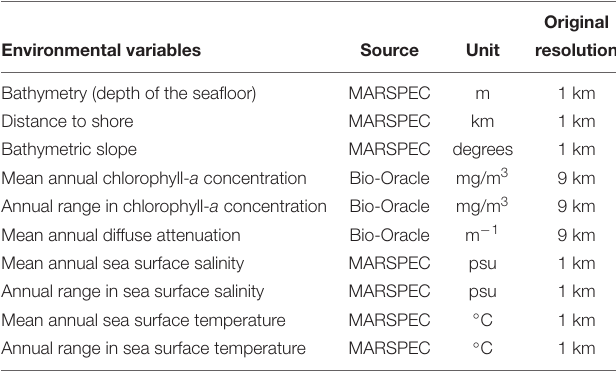
TABLE 1 | List of environmental variables used in this study and their respective source, original grid resolution, and unit of measurement.